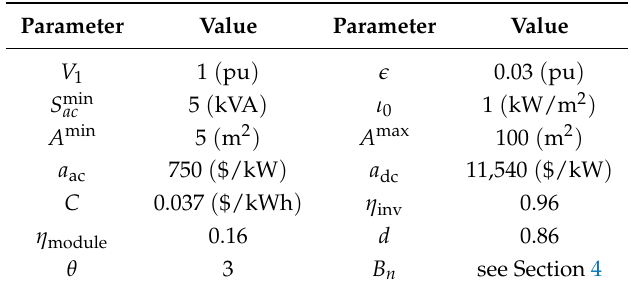
Table 3. Optimization problem parameters.